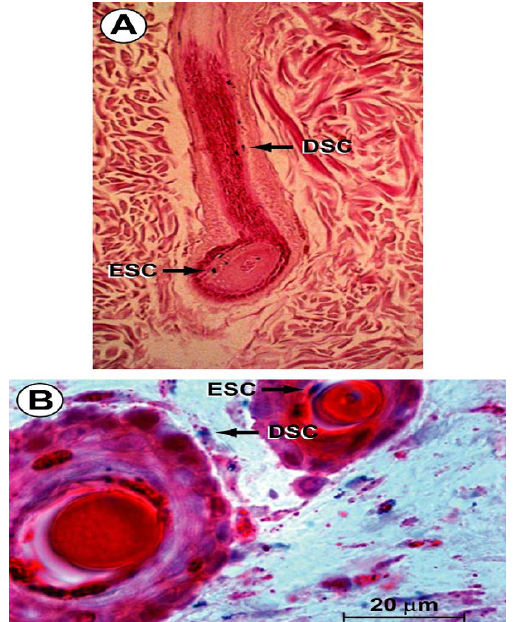
Figure 3. Photomicrographs of cord lining-epithelial cells (A) and cord lining-mesenchymal cells (B). Reproduced from [12] with permission from